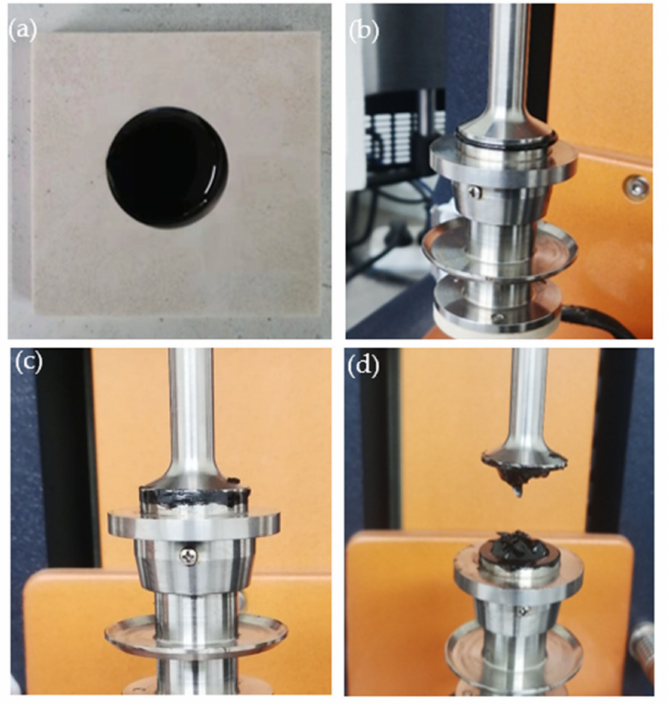
Figure 1. ( a ) test sample, ( b ) sample sandwiched between 25 mm-diameter parallel plates, ( c ) trimmed sample before loading, and ( d ) sample after the